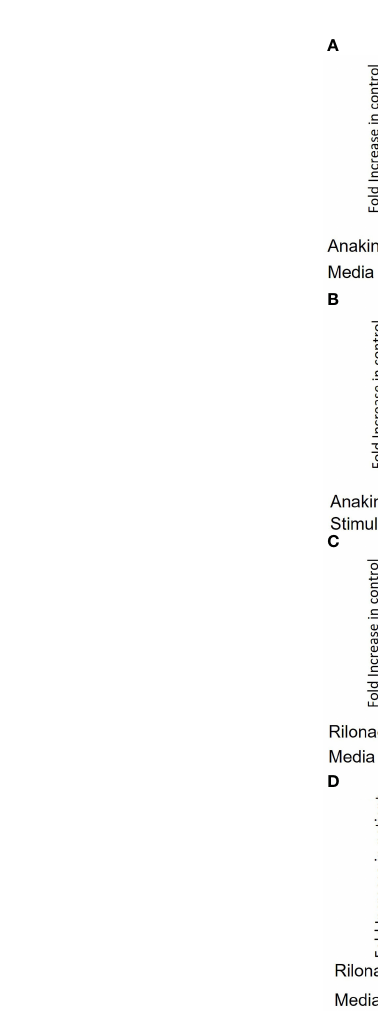
FIGURE 7 Inhibiting IL-1 signaling when stimulating monocytes with tumor line-conditioned medium reduces expression of COX-2 but does not eliminate it. (A) Control monocytes from four individuals were treated with increasing concentrations of anakinra, a small molecule inhibitor of the IL-1 receptor, and then stimulated with conditioned medium from SCC-25 and SCC-154. COX-2 mRNA was measured by q-RT PCR. Bars indicate mean ± SD relative to control fresh medium. Only a subset of monocytes showed a reduction in COX-2 mRNA. (B) Control monocytes from four individuals were treated with anakinra as in “ A ” , then stimulated with increasing concentrations of recombinant IL-1 a . Bars indicate mean ± SD relative to fresh medium (Con.) COX-2 mRNA levels were reduced almost to control levels at all concentrations of anakinra, con fi rming that the inhibitor is effective and in excess. (C) Conditioned medium from SCC-25 and SCC-154 was pre-incubated with increasing concentrations of rilonacept, a recombinant IL-1 trap, and used to stimulate control monocytes from fi ve individuals. COX-2 mRNA was measured by q-RT PCR. Results are expressed relative to monocytes stimulated with fresh medium (Con.) Bars indicate mean ± SD. Only a subset of monocytes was completely blocked from responding. The highest level of COX-2 mRNA expression at each concentration of rilonacept represents monocytes from the same donor. (D) Monocytes from four patients were stimulated with rilonacept-treated conditioned medium as described in “ C ” . Results are expressed relative to monocytes stimulated with fresh medium (Con). Bars indicate mean ± SD. Again, there was heterogeneity in response of monocytes to reduction in IL-1 a stimulation although all patient-derived monocytes showed complete inhibition with the highest concentration of rilonacept-treated medium from SCC-154. Together, this data suggests that IL-1 is a major tumor paracrine factor inducing COX-2 in monocytes, but monocytes from some individuals are responding to additional factors secreted from the tumor